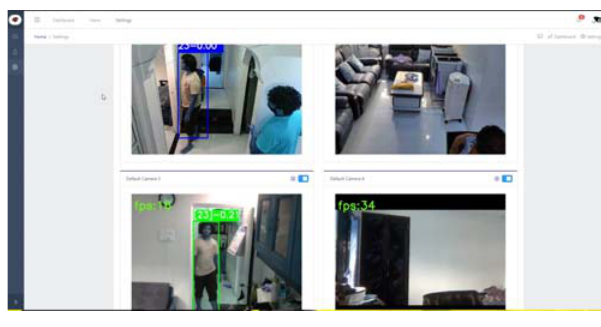
Fig16: Initialization of the system